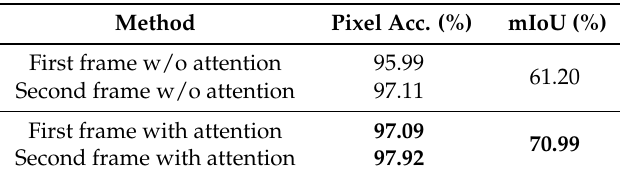
Table 1. Comparison of the accuracies from our framework without (w/o) and with the attention module on the ObMiC validation dataset in pixel-wise accuracy (Pixel Acc.) and on the ObMiC testing dataset in mIoU accuracy (mIoU). Numbers in bold are the best